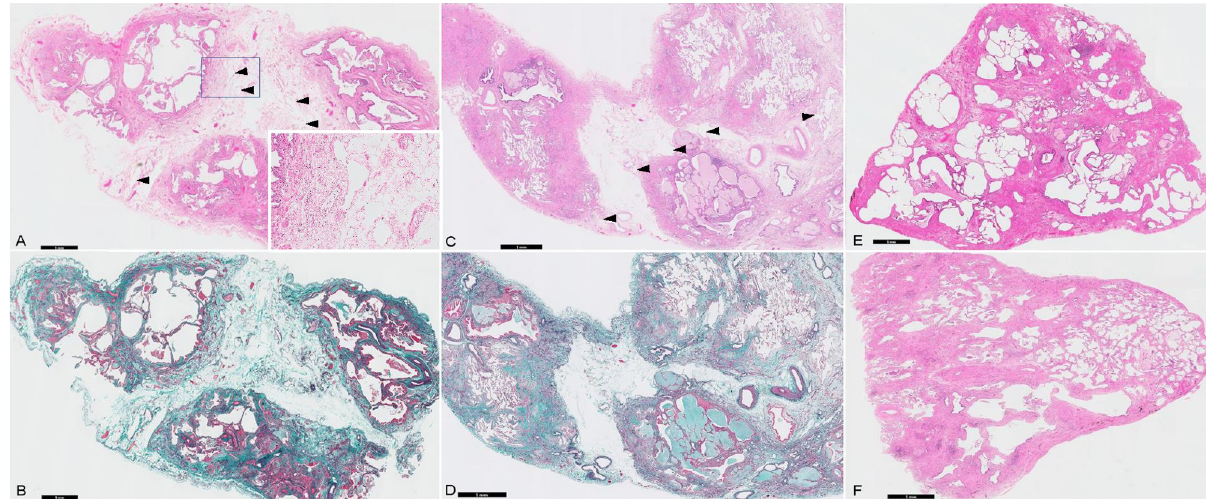
Fig 2. Representative image of edematous changes in the interlobular septum (ECIS) from a surgical lung biopsy sample. (A, B) and (C, D) are two cases of ECIS with remarkable oedema and interlobular septal thickening. The dilated lymph vessels (arrowheads) support the presence of an oedema as a true finding and not an air contamination during the specimen preparation. (E, F) are images of a patient without ECIS. (A, C, E, and F) Haematoxylin and eosin staining. (B, D) Elastica van Gieson staining. The black bars show the magnification.